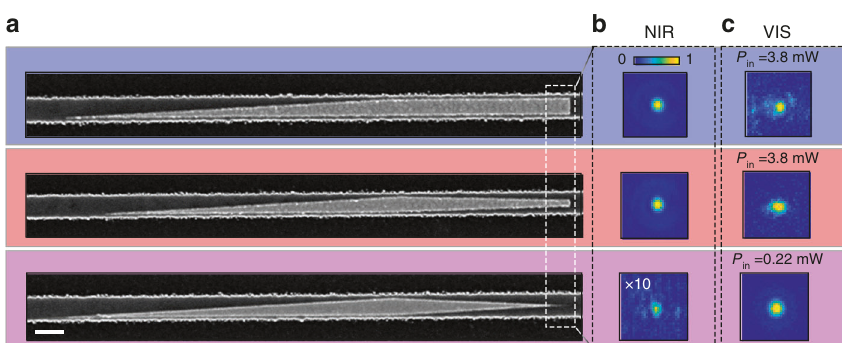
Fig. 5 Measurements of pump- and second-harmonic light scattered by the gold nanotips. a SOI-HPIC scanning electron micrographs, with tip width of 300 nm (blue), 138 nm (red), and 10 nm (magenta). Measured scattering from the SOI-HPIC b in the NIR c and visible. Images in ( b ) and ( c ) are respectively captured under the same conditions, unless otherwise indicated. P in is the average power incident onto the input grating for the three captured images in ( c ). The color bar represents the number of counts measured in ( b ) and ( c ), divided by the maximum number of counts in ( b ) and ( c